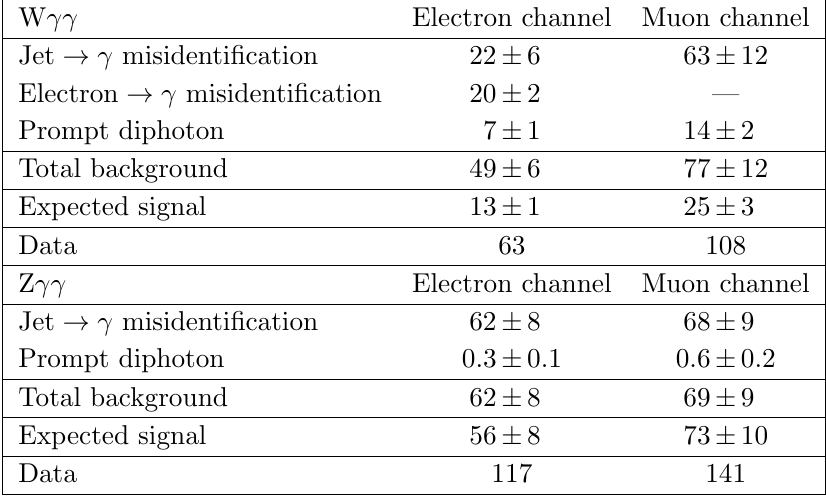
Table 1 . Background composition, expected signal, and observed yields in the W (cid:13)(cid:13) (upper) and Z (cid:13)(cid:13) (lower)